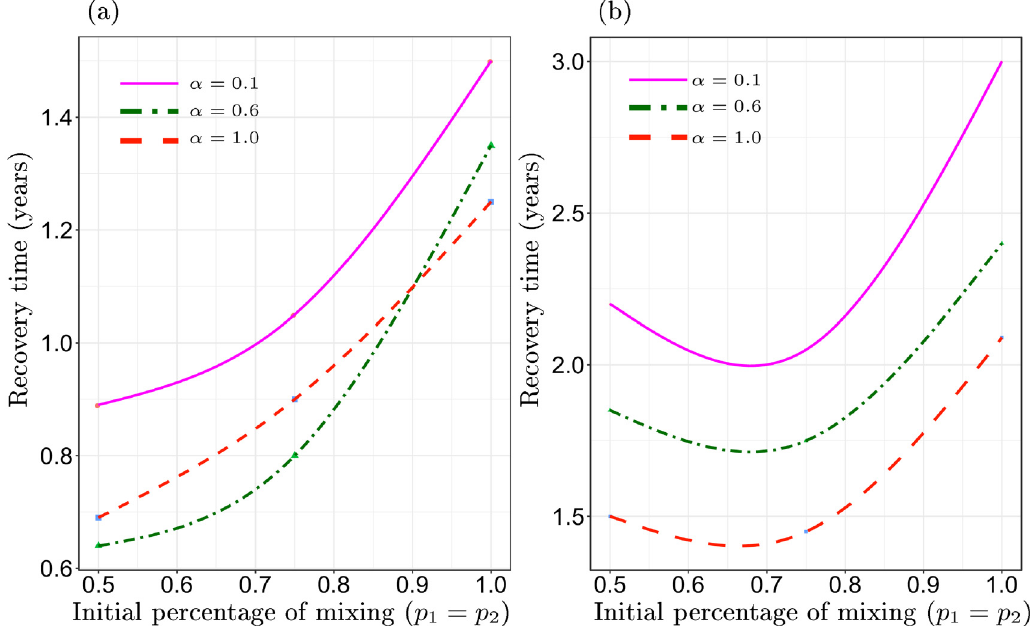
Fig 6. The recovery time (y-axis) it takes a population of foragers to consistently meet their calorie target following a perturbation to habitat one (a drought) for different levels of initial cycling (x-axis). Graph (a) population density is 1/4 of the maximum population density recorded in Fig 5 for a given level of resource oscillation ( α ). Graph (b) population density is 1/2 of the maximum recorded in Fig 5. In general, the graphics illustrate that full partitioning drastically increases recovery time from a